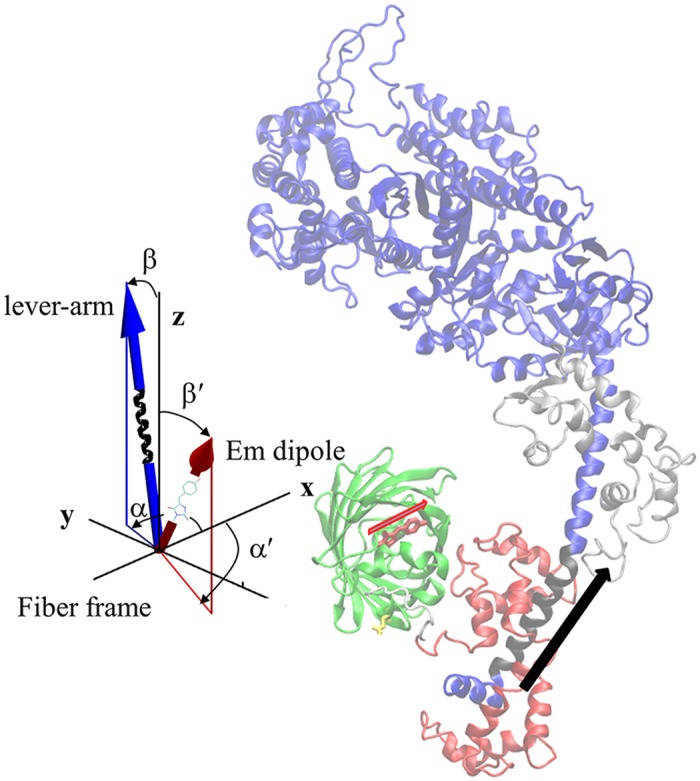
The coordination of the GFP moiety (green) and its emission dipole moment (red arrow) with myosin S1 consisting of a heavy chain (blue and black), ELC (silver), and RLC (red).The portion of the lever-arm in the heavy chain appearing in black is the α-helix segment associated with the lever-arm orientation and depicted by the black arrow. The insert shows the time-resolved coordinates for GFP chromophore emission dipole moment in red and lever-arm helix in blue corresponding to spherical polar angles (β’,α’) and (β,α) defined relative to a fiber fixed frame.